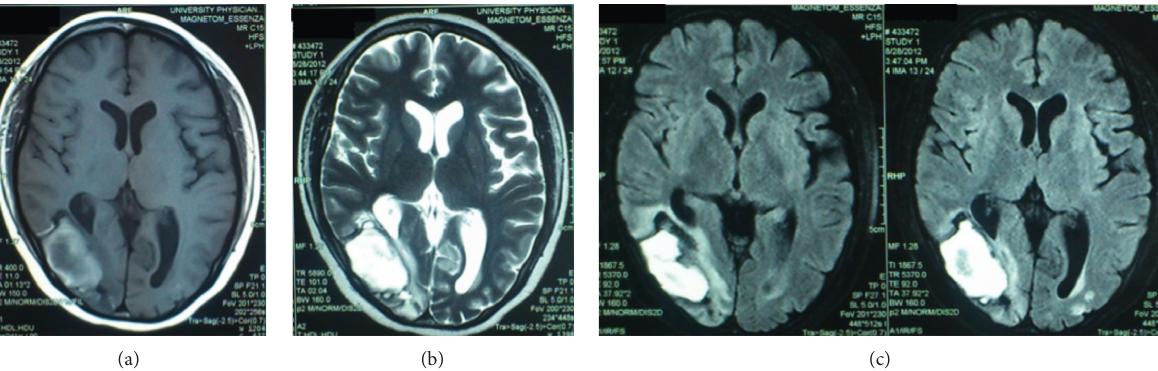
Figure 3: Plain cranial MRI images of the patient. (a) T1-weighted MR image demonstrating a hyperintense hematoma with hypointense core on the right occipital lobe, compressing the occipital horn of the right lateral ventricle, (b) T2-weighted MR image showing hy- perintense signals of the same hematoma with surrounding vasogenic edema, and (c) FLAIR MR images demonstrating cortical-subcortical signal abnormalities on the right as well as left occipital